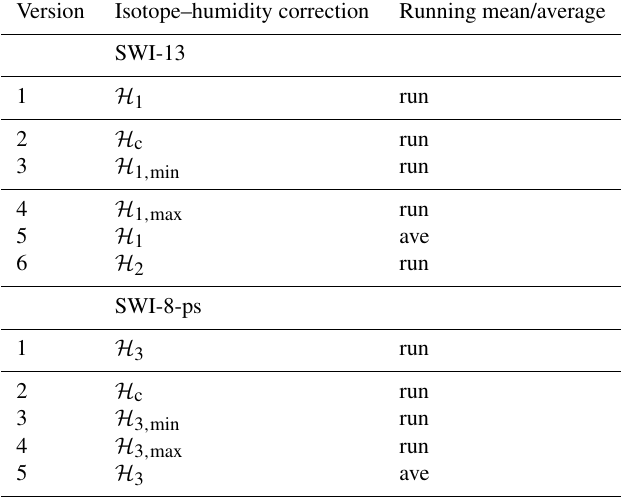
Table A1. Calibration versions of SWI-13 and SWI-8-ps used in this study. The following isotope–humidity dependency correction functions are used in the calibration versions: H c applies a constant factor of 0 as correction term (i.e. no isotope–humidity dependency correction is used). H 1 , min and H 1 , max are the best fit correction curves to the SWI-13 calibration runs ± 1 standard deviation to es- timate the uncertainty of the best fit ( H 1 ) to the calibration runs.